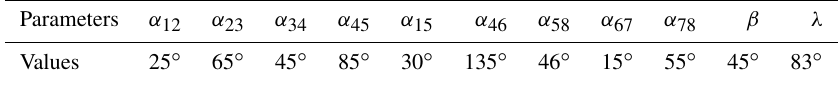
Table 2. Parameters of spherical parallel manipulation in Fig. 4.